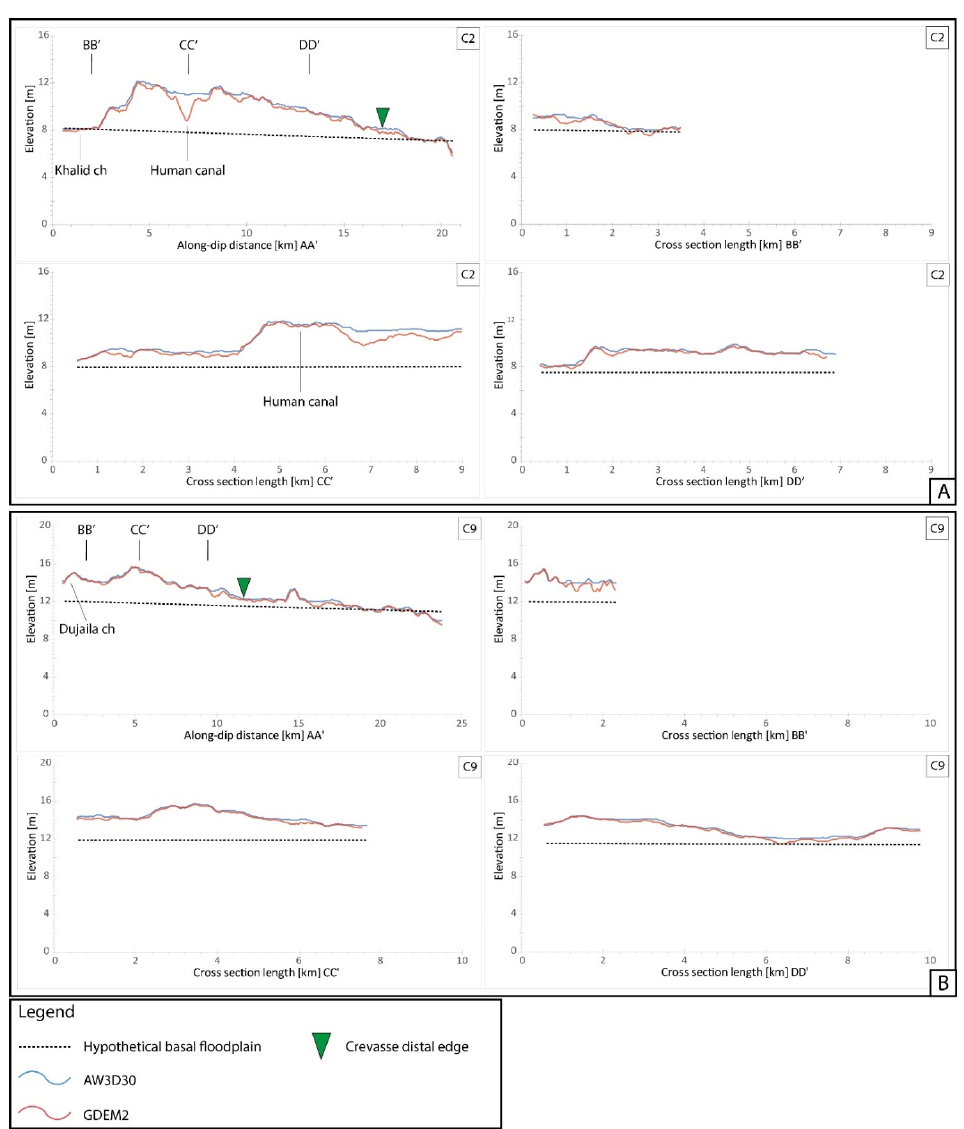
Figure 9. Altimetric profiles based on elevation data of both AW3D30 (blue line) and GDEM2 (red line) datasets. Moving averaged values range from 8 up to 20 m. Location of the profile traces are reported in Figure 5. ( A ) Altimetric profiles for the crevasse C2; ( B ) Altimetric profiles for the crevasse C9.